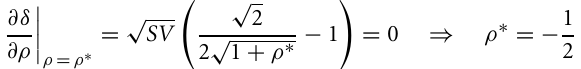
FIGURE 3 | The distance between the two phase transitions ( δ ) as a function of the pairwise interaction correlation ρ for S = 250 and C = 0 . 2. The maximum distance and the corresponding pairwise correlation are indicated using blue dashed lines, and the correlations for the three numerical simulations in Figure 2 are marked by black dashed